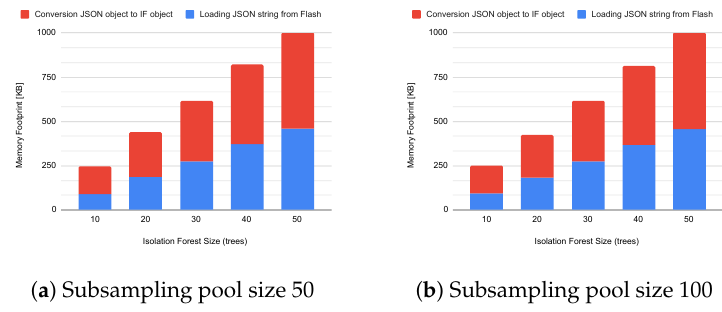
Figure 6. Loading memory footprint with subsampling pool of 50 ( a ) and 100 instances ( b ). Figure 7 shows the stack of the two loading phases.